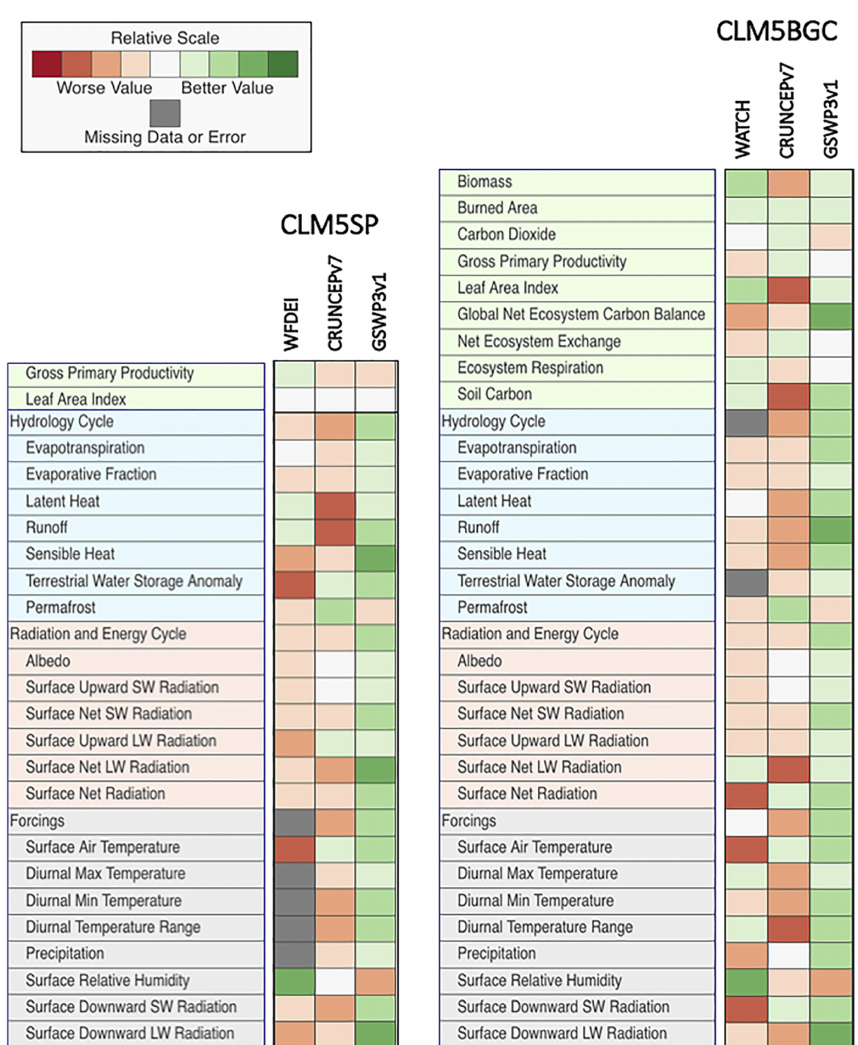
Figure 3. Validation results for terrestrial variables within the CLM5 by Lawrence et al. (2019) using ILAMB analysis (Collier et al., 2018) including three different climate forcing data products (individual columns) and two forms of model structure (column groups). CLM5SP denotes MODIS-prescribed (Zhao et al., 2005) vegetation phenology, while CLM5GBC denotes prognostic phenology. Climate forcing data products include WATCH/WFDEI from Mitchell and Jones (2005), CRUNCEPv7, the default forcing dataset used by the Global Carbon Project (Le Quéré et al., 2018), and GSWP3v1, the default forcing dataset used in the Land Surface, Snow and Soil Moisture Model Intercomparison Project (van den Hurk et al., 2016). This figure was made available under a Creative Commons Attribution License (CC